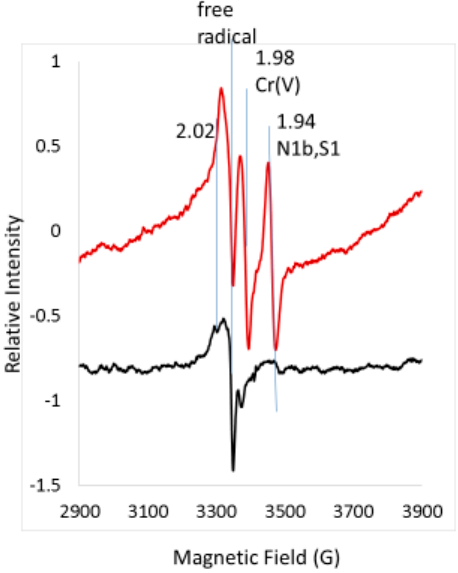
Figure 2. EPR spectra for untreated white blood cells (black) versus those treated with 400 μ M chromate (red). Cells were incubated at 37 °C for 3 h. Vertical lines indicate superposition of lines from several sites (g = 2.02), Cr(V) (g = 1.98) and the N1b and S1 2Fe2S centers (g = 1.94–1.93). Spectrometer conditions: microwave freq., 9.387 GHz; temp., 10 K; mod. amp., 5 G; microwave power, 5 mW; sweep time, 83.89 s; time constant, 81.82 ms; nine scans.